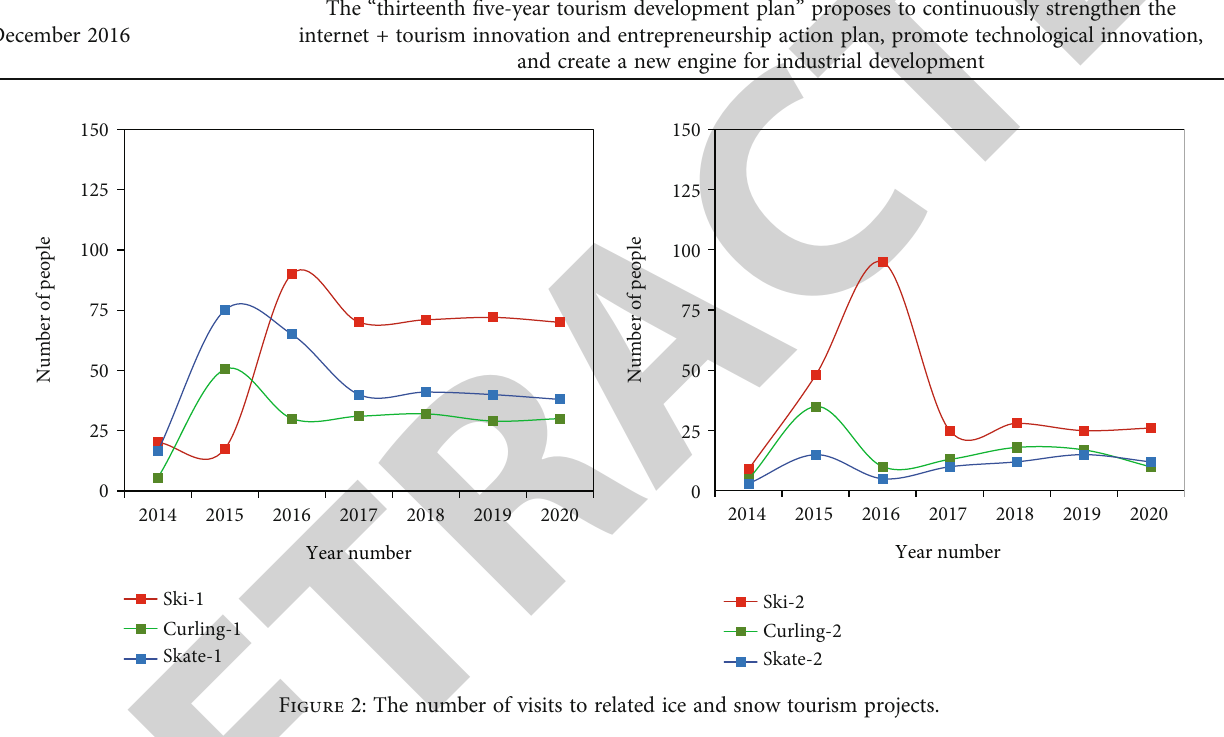
Figure 2: The number of visits to related ice and snow tourism